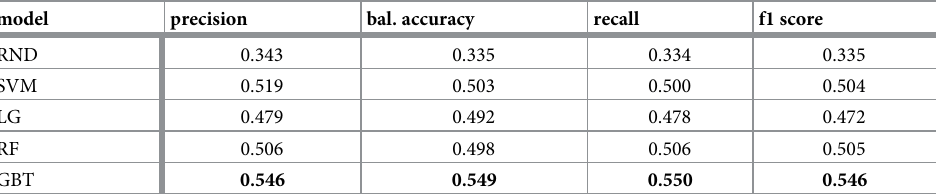
Table 2. Classification performance.